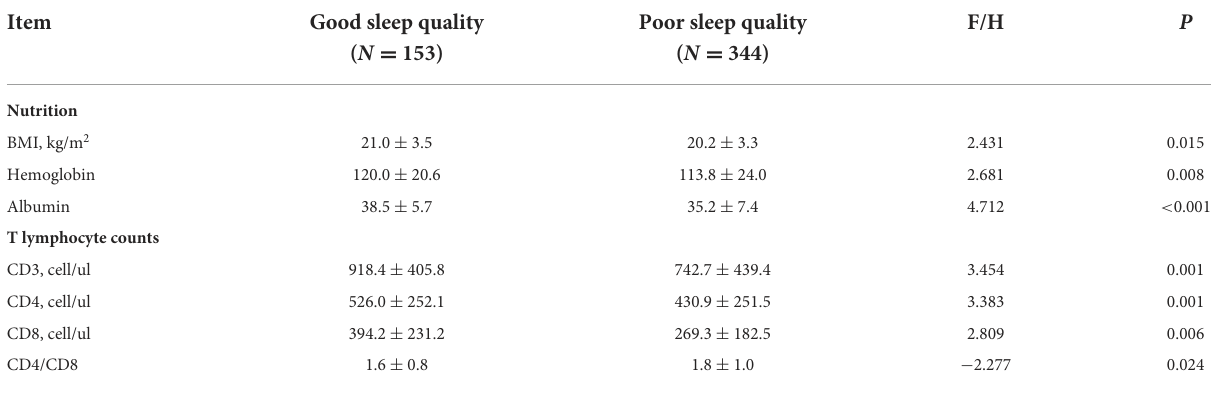
TABLE 3 Nutrition and immune parameters in patients with